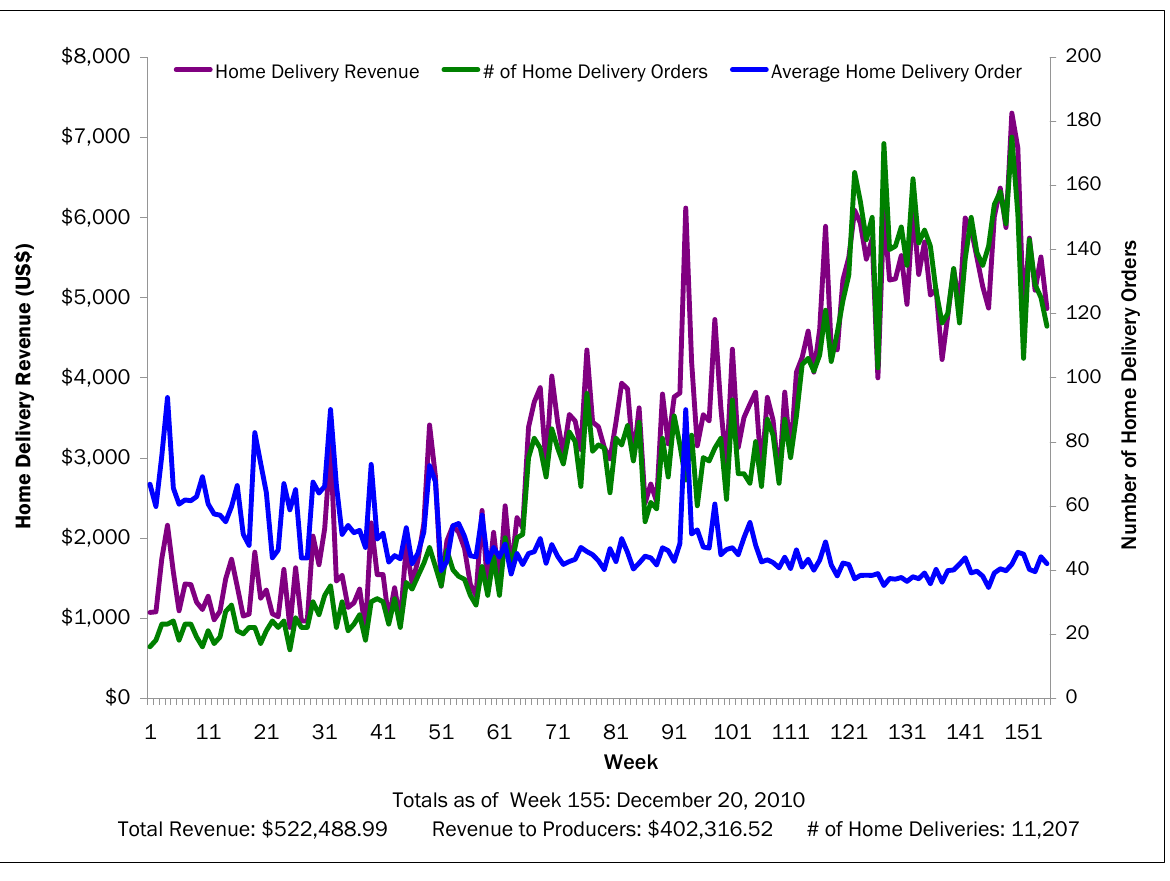
Figure 3. CNY Bounty Home Delivery Revenues and Orders (Excluding Wholesale),